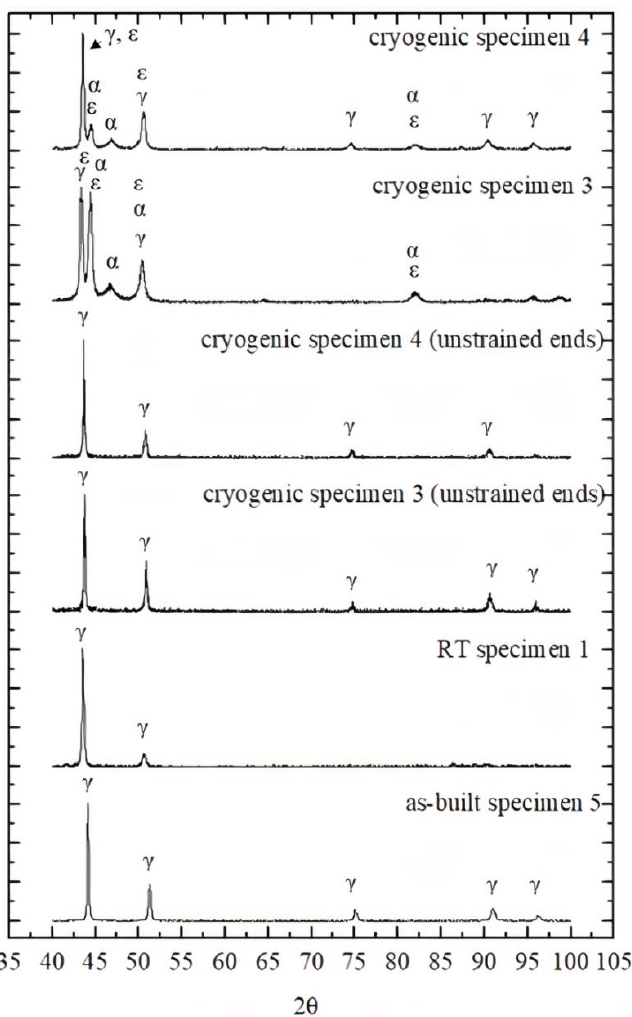
Figure 6 . XRD patterns of the room temperature specimen 1, − 196 °C temperature specimens 3 and 4, and as-built specimen 5. XRD patterns of the cryogenic specimen 3 and specimen 4 with unstrained ends are also shown.